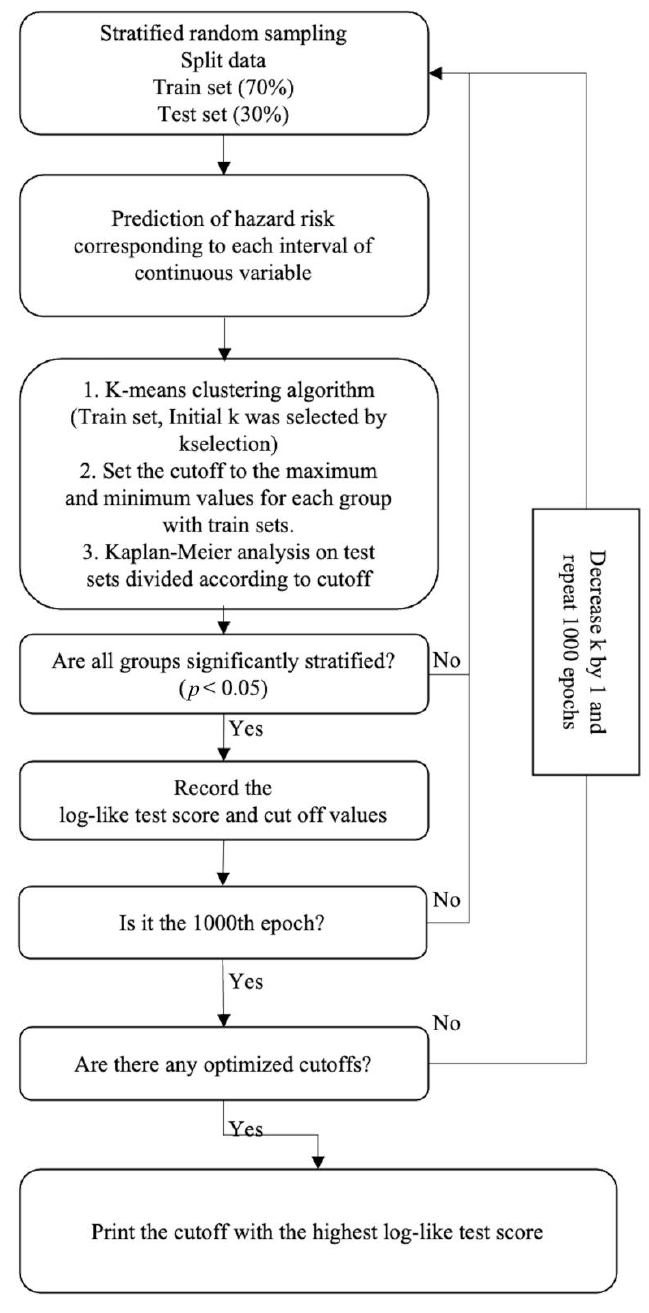
Figure 1. K-means clustering algorithm.